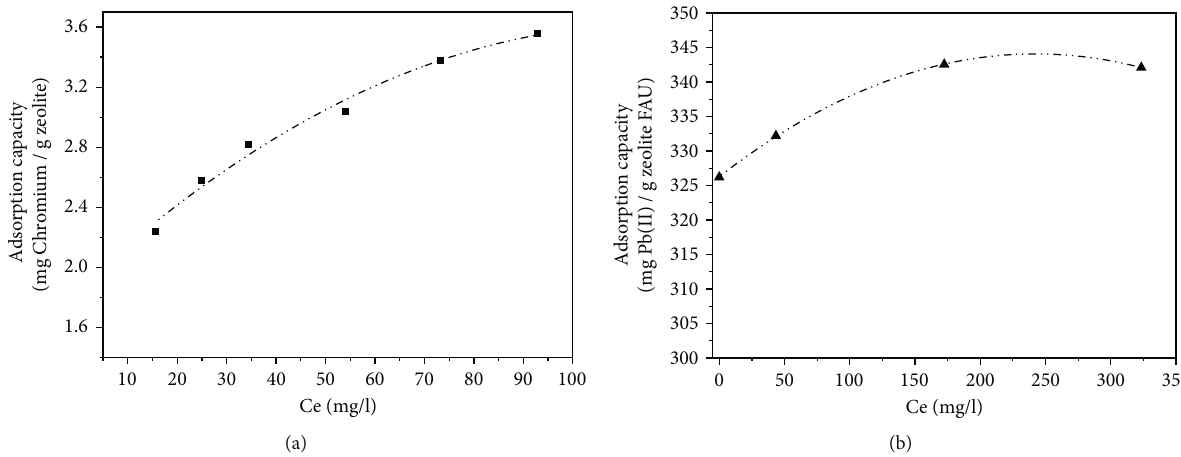
Figure 5: E ff ect of metal ion concentration on the removal of (a) Cr(VI) and (b) Pb(II) from aqueous solution by using RHA-based zeolite Table 1: Comparison of notable aluminium-rich zeolites for Pb(II) and Cr(VI) removal from aqueous solution. Adsorbent